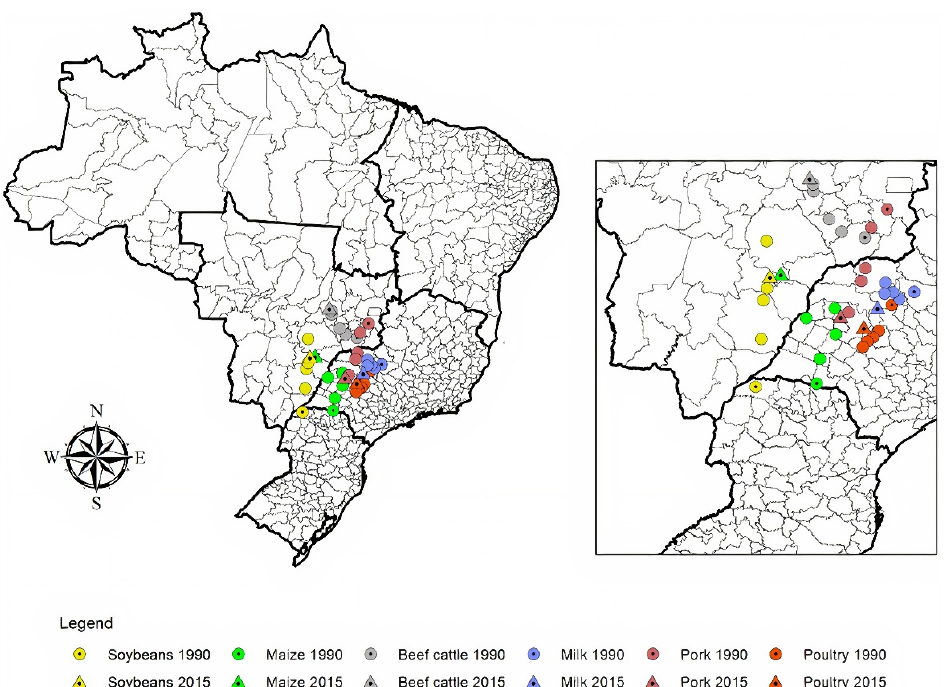
Figure 2. Annual midpoints of the production of soybeans, maize, beef cattle, milk, pork, and poultry in Brazil from 1990 to 2015. Source: Elaborated by authors based on [22,23]. Notes: each microregion as represented by the gray lines has different territorial dimensions.